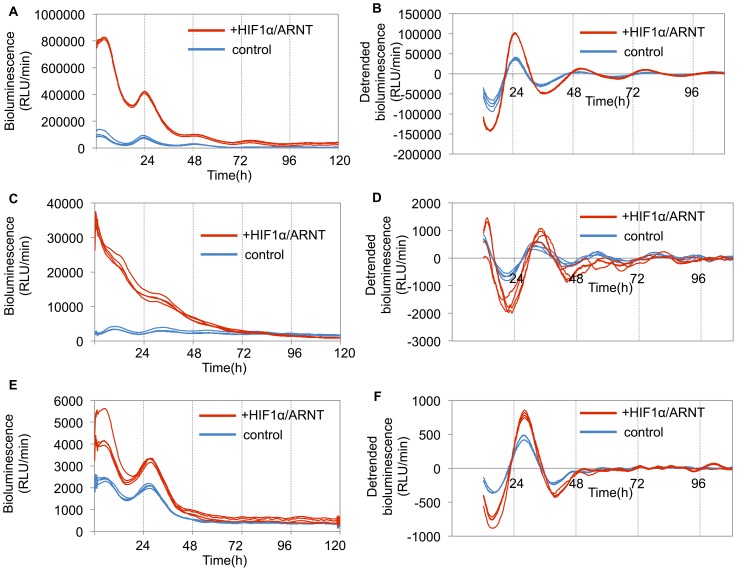
The impact of HIF1α/ARNT on Per2 transcriptional activity.(A) NIH3T3 cells were co-transfected with the Per2 promoter reporter (400 ng) and the indicated expression plasmids (300 ng) for HIF1α/ARNT or empty vector pcDNA3 (600 ng) as a control. Bioluminescence was then measured using a real-time monitoring assay. Control, transfected with empty vector pcDNA3 (uncloned-vector control); + HIF1α/ARNT, transfected with the expression plasmids. Luciferase activities of four replicate samples are shown. (B) Detrended bioluminescence is shown. Period, amplitude, and acrophase of the oscillations were measured on days 2 to 5 using the Cosinor software (Circadian Rhythm Laboratory). Amplitude significantly increased (mean ± SEM, n = 4) compared to the control (p<0.01, Student's t-test). See Table 2. (C) U2OS cells were co-transfected with the Per2 promoter reporter (400 ng) and the indicated expression plasmids (300 ng) for HIF1α/ARNT or empty vector pcDNA3 (600 ng) as a control. Bioluminescence was then measured using a real-time monitoring assay. Control, transfected with empty vector pcDNA3 (uncloned-vector control); + HIF1α/ARNT, transfected with the expression plasmids. Luciferase activities of four replicate samples are shown. (D) Detrended bioluminescence is shown. Period, amplitude, and acrophase of the oscillations were measured on days 2 to 5 using the Cosinor software (Circadian Rhythm Laboratory). Amplitude significantly increased (mean ± SEM, n = 4) compared to the control (p<0.01, Student's t-test). See Table 2. (E) Caki-2 cells were co-transfected with the Per2 promoter reporter (2 µg) and the indicated expression plasmids (1.5 µg) for HIF1α/ARNT or empty vector pcDNA3 (3 µg) as a control. The bioluminescence was then measured using a real-time monitoring assay. Control, transfected with empty vector pcDNA3 (uncloned-vector control); + HIF1α/ARNT, transfected with the expression plasmids. The luciferase activities of four replicate samples are shown. (F) Detrended bioluminescence is shown. Period, amplitude, and acrophase of the oscillations were measured from days 2 to 5 using the Cosinor software (Circadian Rhythm Laboratory). Amplitude significantly increased (mean ± SEM, n = 4) compared to the control (p<0.01, Student's t-test). See Table 2.